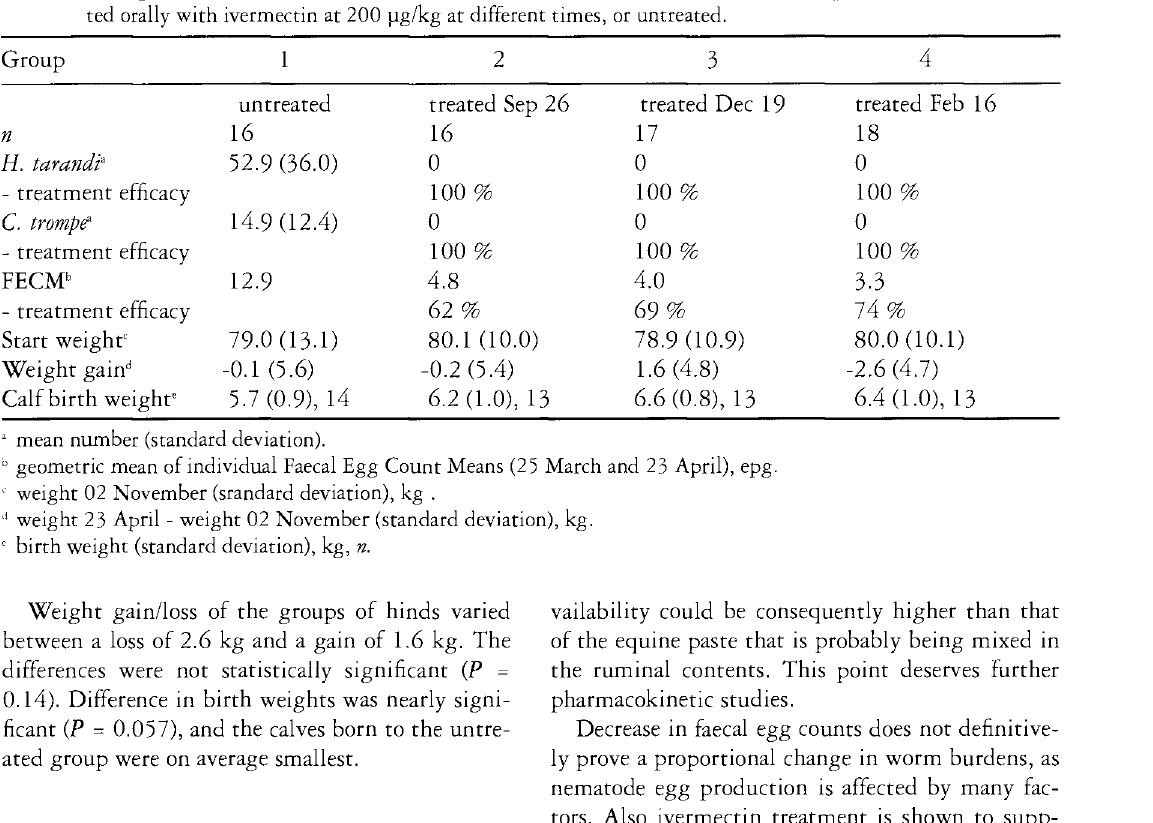
Table 1. Warbles (Hypoderma tarandi larvae) and throat bots (Cephenernyia trompe larvae), trichostrongylid nematode fae cal egg count means, start weights, weight gains, and calf birth weights of the groups of reindeer hinds, trea ted orally with ivermectin at 200 ug/kg at different times, or